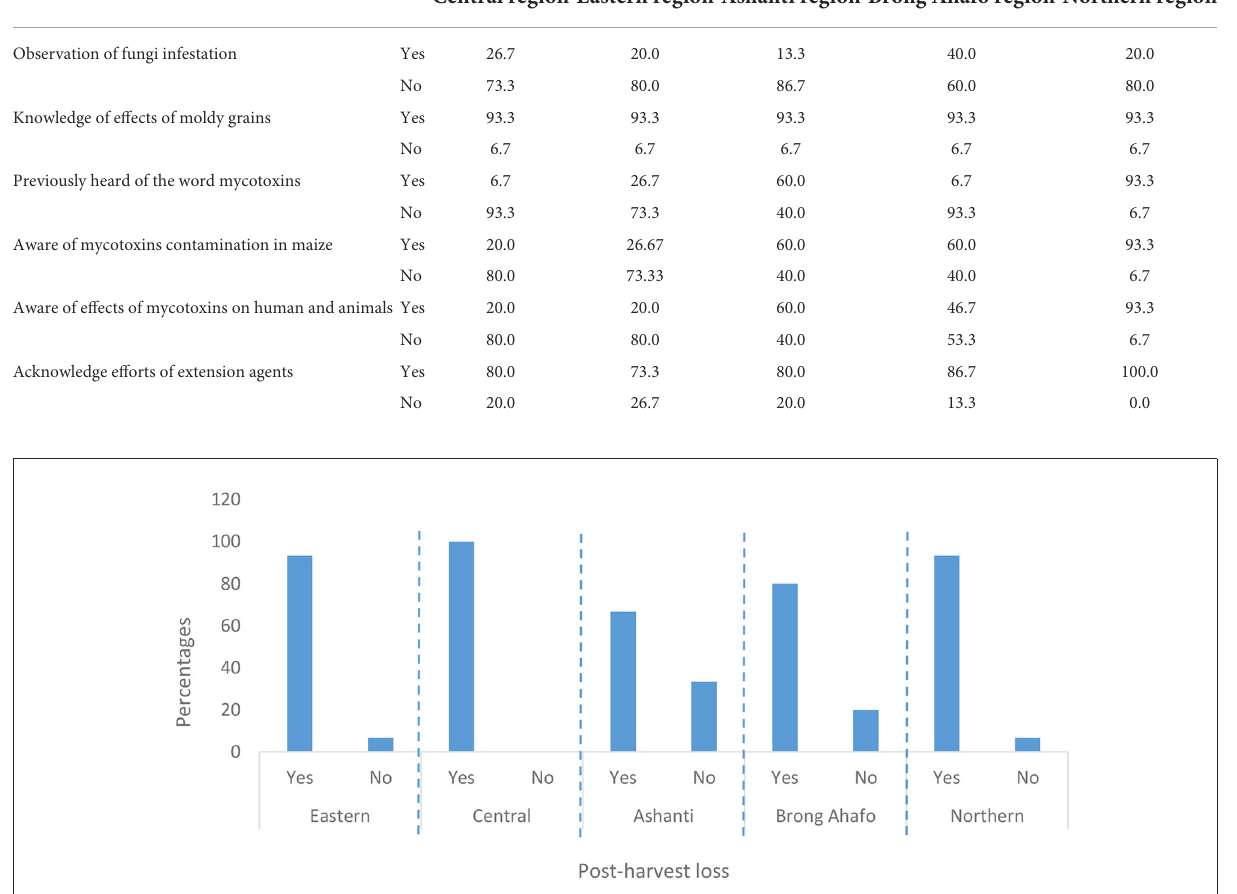
FIGURE7 Percentage of maize farmers that observed post-harvest losses (PHL) in maize